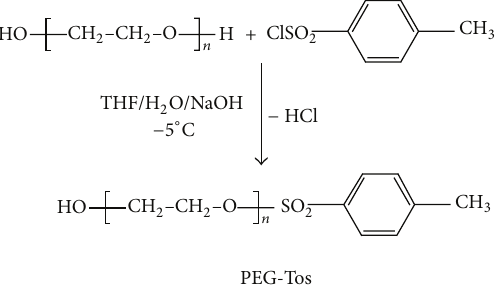
Scheme 1: Synthesis of PEG-Tos.